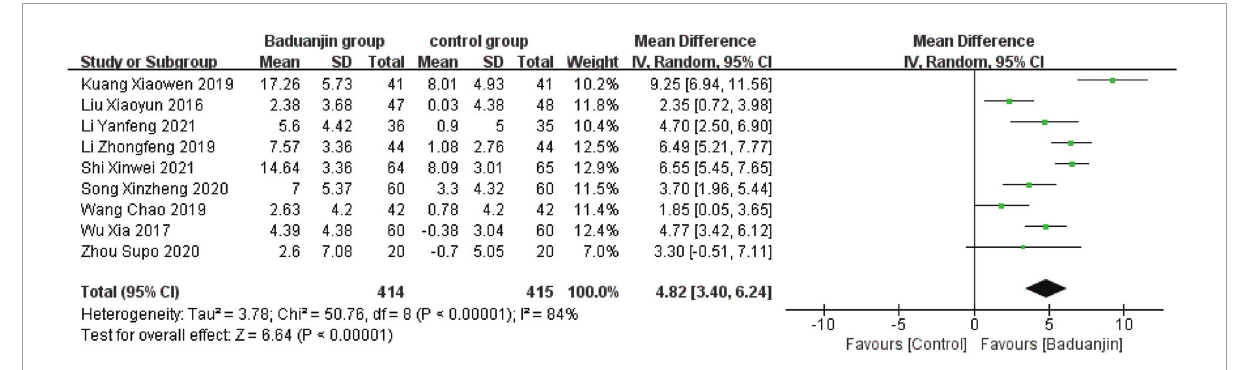
FIGURE3 Forest plot of the meta-analysis of BBS. CI, confidence interval; SD, standard deviation.